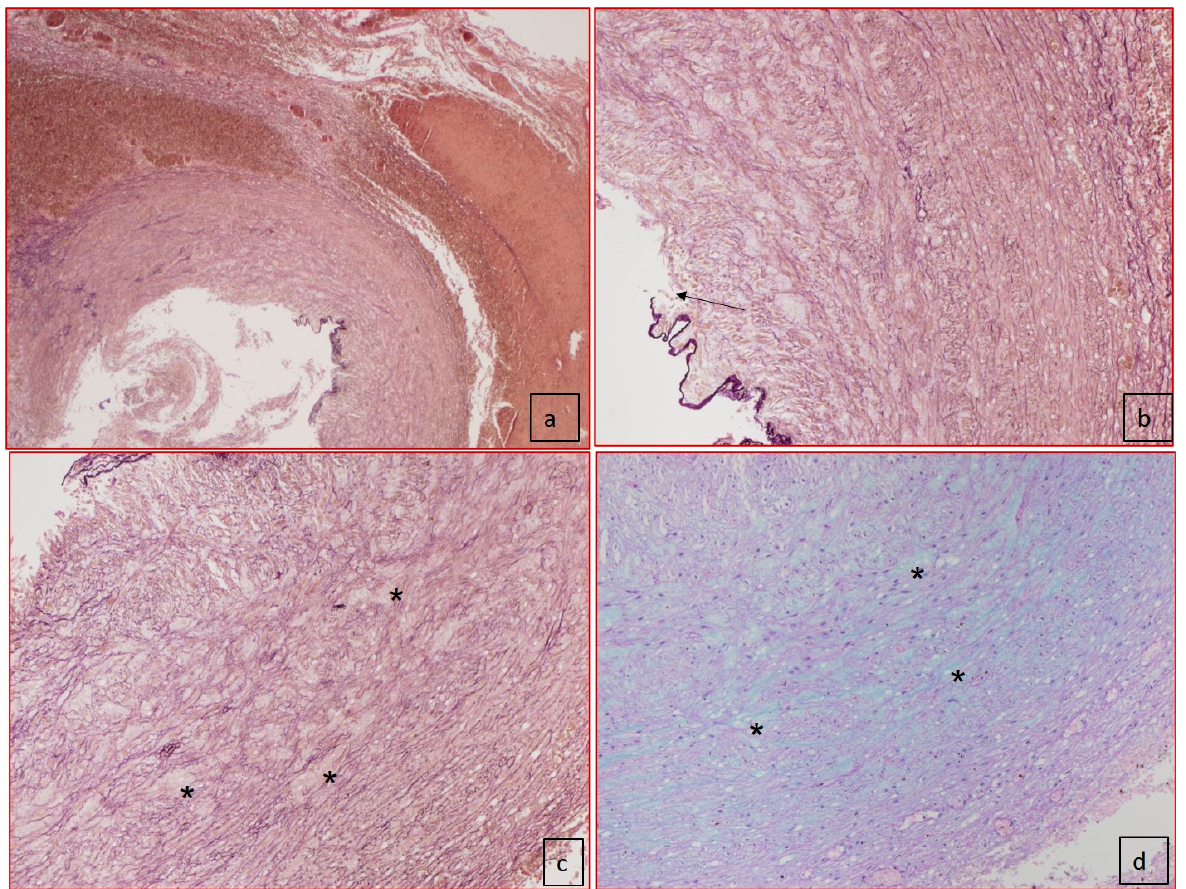
Figure 3. Histology of the ductus arteriosus (case 2). ( a ) Panoramic view of ductus arteriosus with elastic fiber–van Gieson staining showed the dissection of media (50× of magnification) and the absence of intimal cushions. ( b ) Elastic fiber–van Gieson staining at higher magnification showed the disorganization of elastic fibers and rupture of internal elastic lamina (black arrow). ( c ) Elastic fiber–van Gieson (100× magnification) staining showing disorganization of elastic fibers and presence of lacunar spaces, cystic medial necrosis (*), without SMCs replaced by mucopolysaccharides as shown in ( d ) with Alcian–PAS staining (100× magnification).